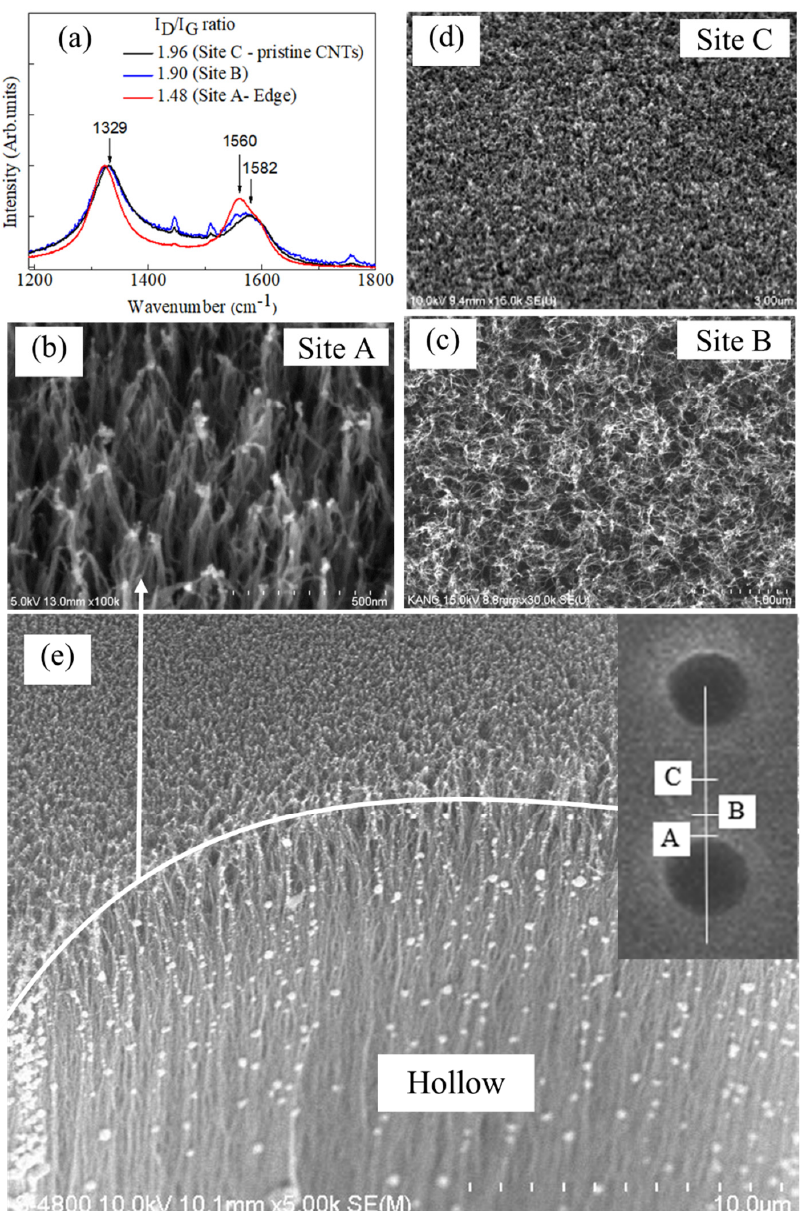
Figure 2. ( a ) Raman spectra of carbon nanotubes recorded at three different sites ( A – C ), which are shown in SEM images ( b – d ); ( e ) Hollow edge of CNTs, Inset: Site A, B, and C positions: ( A ) rim edge of hollow; ( B ) 25 µm away from site A; ( C ) middle between two consectutive hollows.